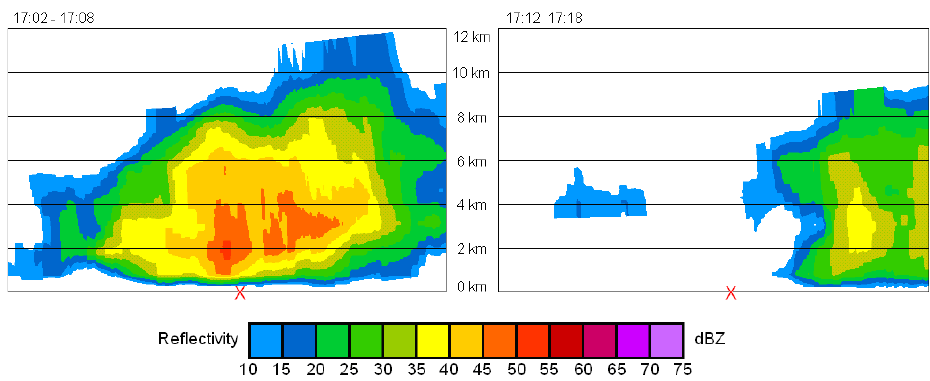
Fig. 2. Vertical cuts of the thunderstorm over the forest (red cross).